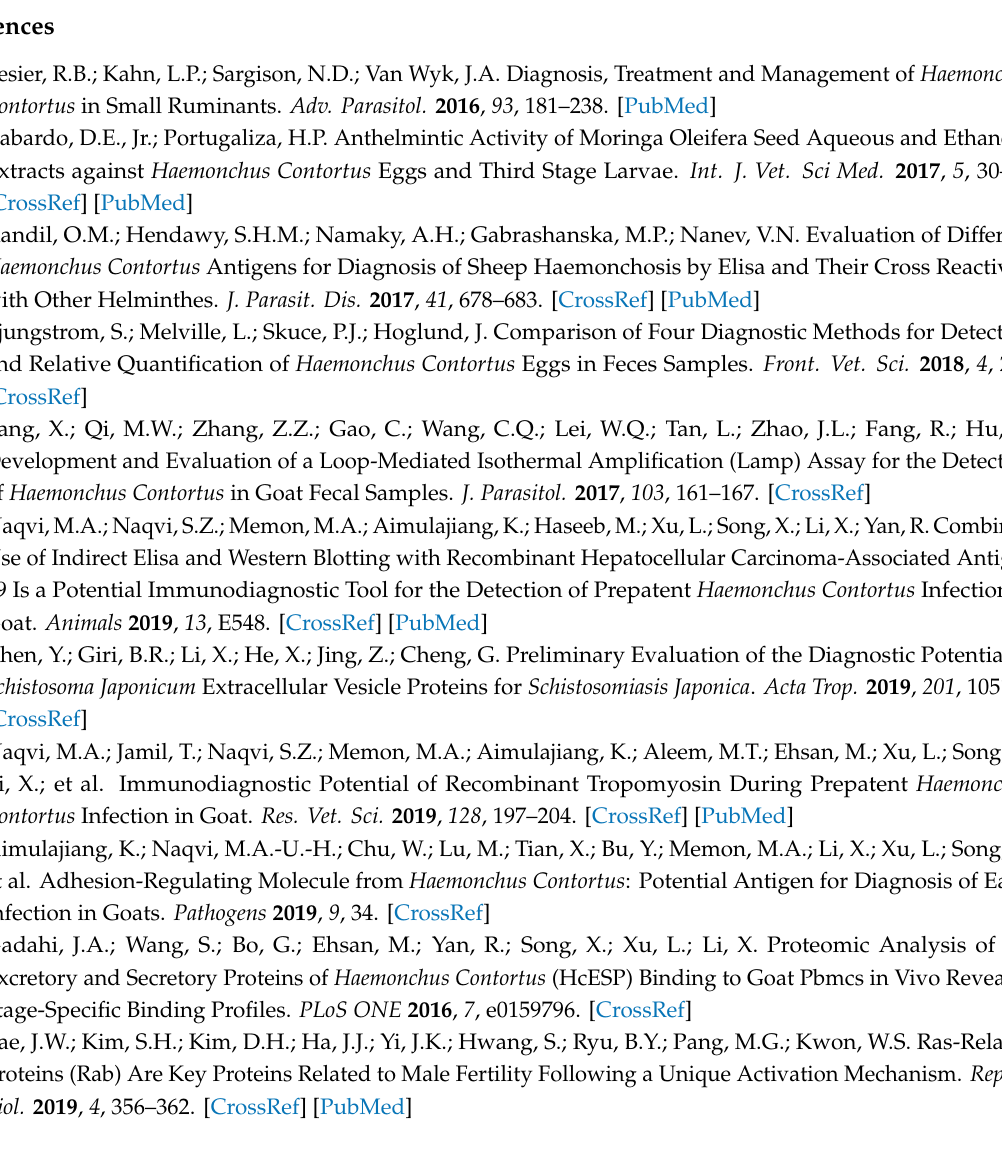
Table S1: Reactions between rHcRas and serum from goat infected with H. contortus ; Table S2: Stability of the indirect